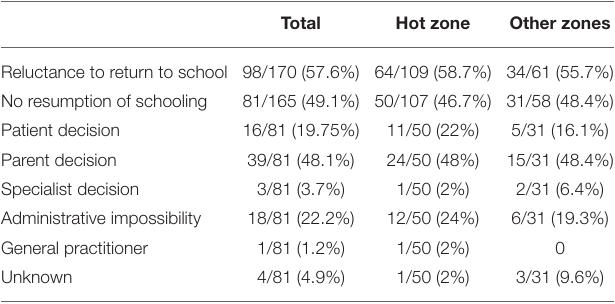
TABLE 3 | Returning to school in the JIA population. Total Hot zone Other